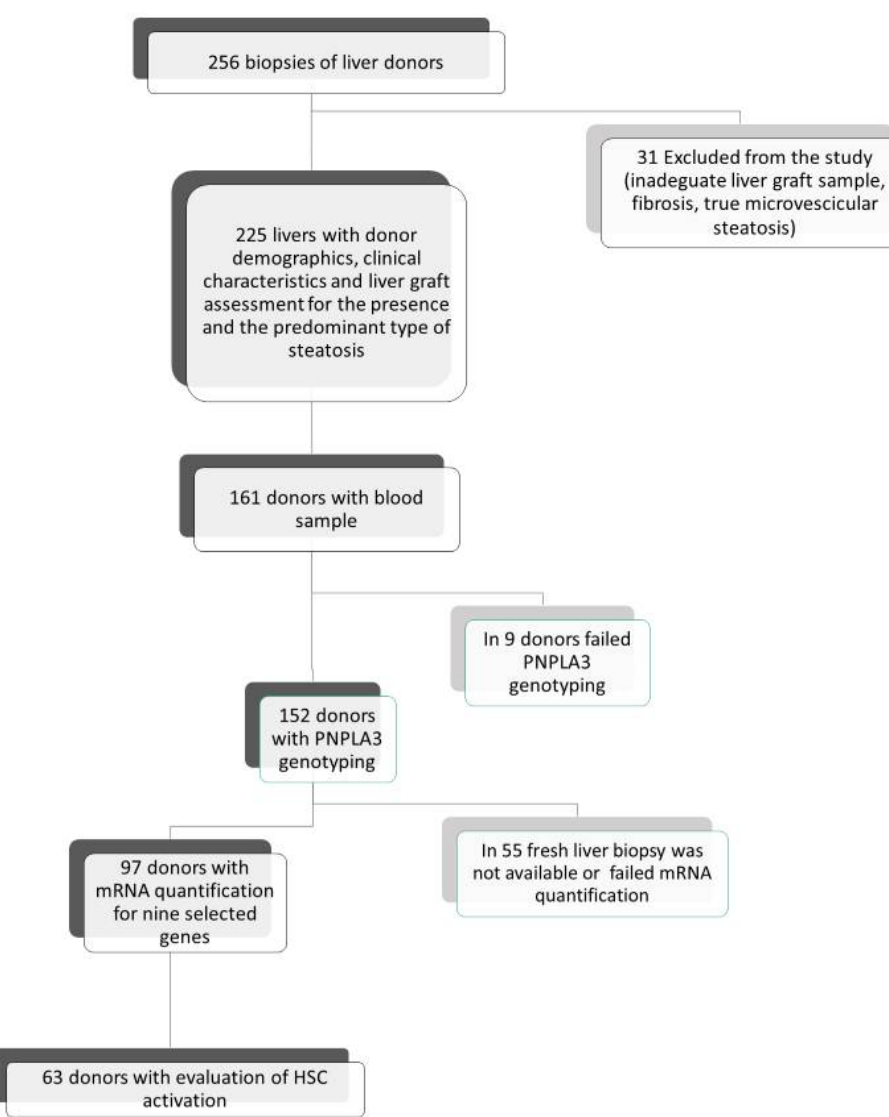
Figure 5. Study population at the time of liver transplantation. Flow chart of the enrolled liver donors according to the presence and the predominant type of steatosis and subgroups analyzed for donor PNPLA3 genotyping, liver graft ex- pression of genes involved in lipid metabolism and activation of